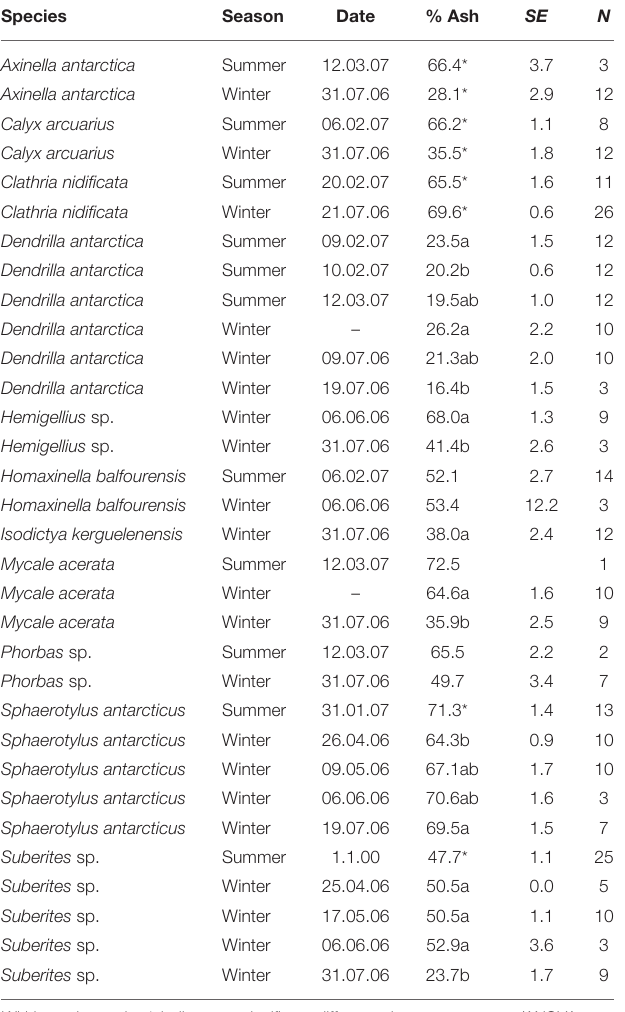
TABLE 2 | The % ash content of dried tissues of sponge species in summer and winter. Species